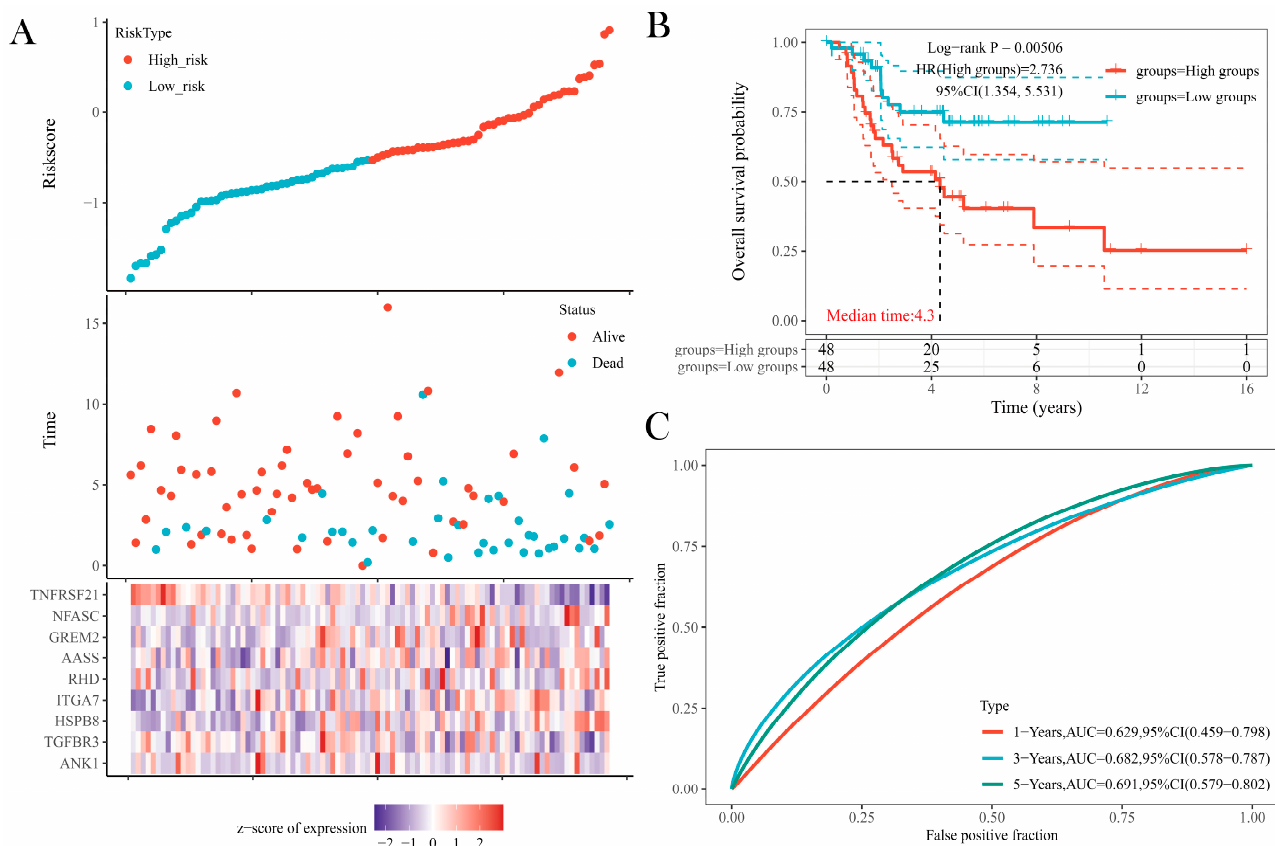
Figure 8. ( A ) Risk curves, survival status charts and risk heatmap for patients with osteosarcoma. The horizontal coordinates are risk values, and the vertical coordinates are risk scores, patient survival time (years) and nine representative genes. ( B ) The graph examines the effect of high- and low-risk groups on patient prognosis. The survival curve has the horizontal axis of the observation time and the vertical axis of the survival rate. ( C ) The ROC curve of this risk model at various times with AUC, where better AUC values indicate that the model has better predictive power.